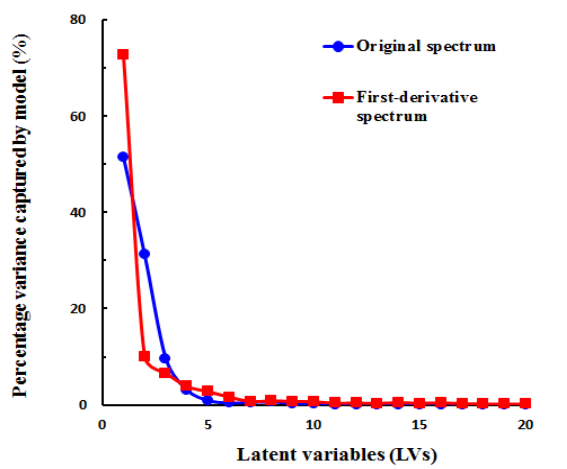
Figure 6. Changes in the variance explained by the latent variables (LVs) based on the original and first derivative canopy